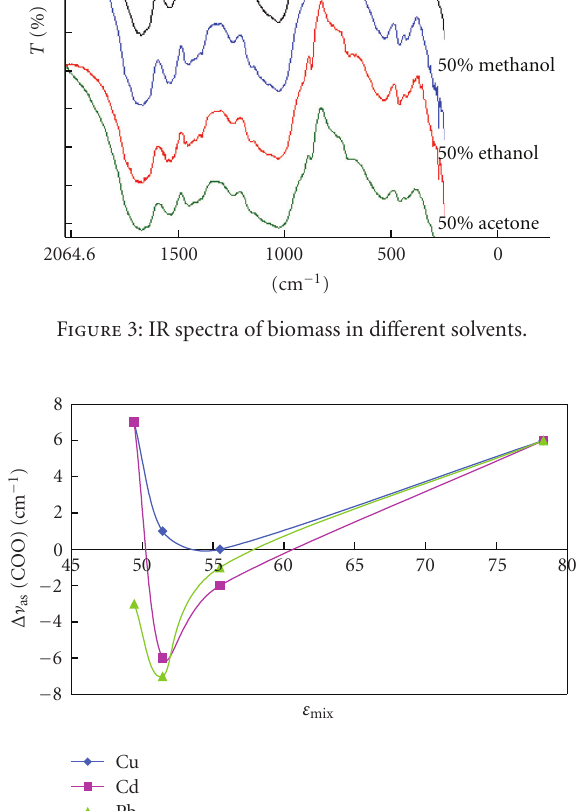
Figure 4: Change in Δ ν as COO with dielectric constant.